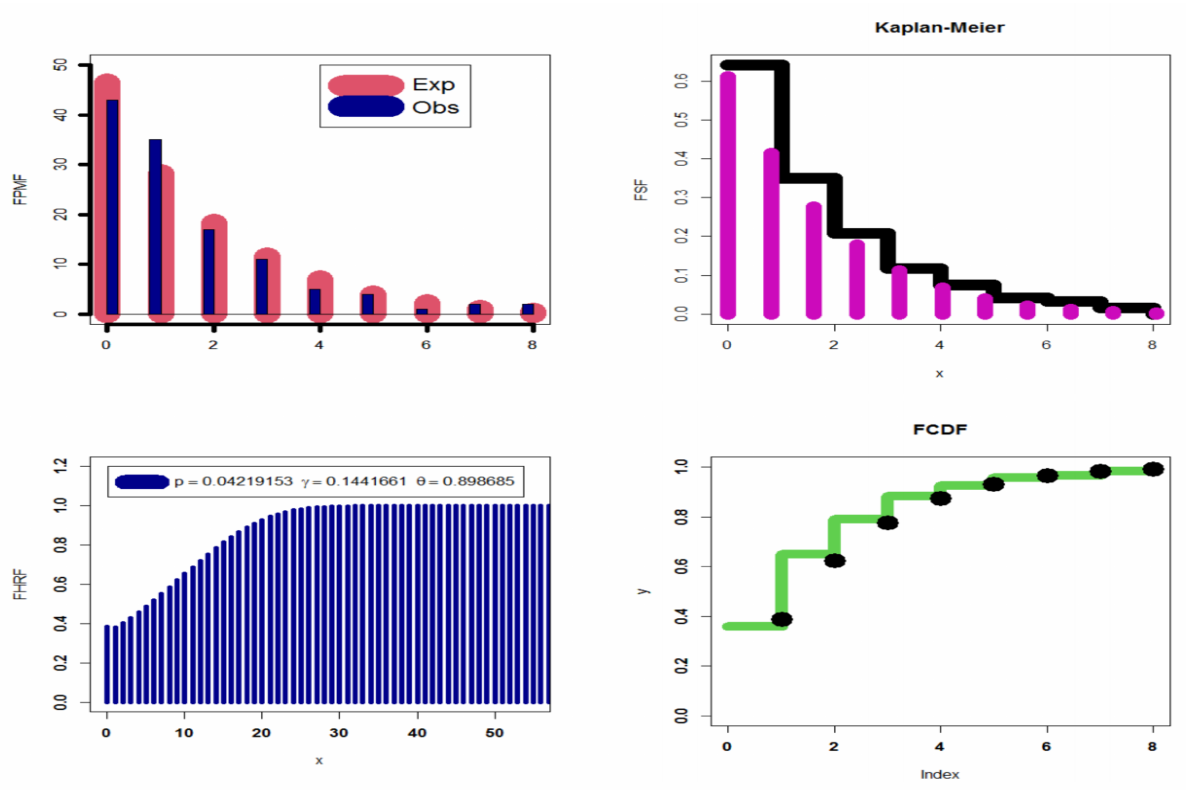
Figure 14. The FPMF, FSF, FHRF, and FCDF plots for dataset IV. Table 20. The goodness-of-fit test statistics for comparing the competitive models for dataset